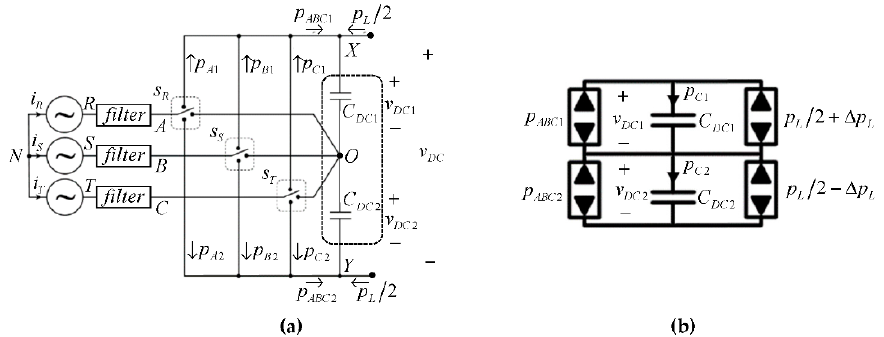
Figure 3. Three-level three-phase power conversion topology. ( a ) Generalized circuitry. ( b ) Power- level equivalent circuit of the DC link.